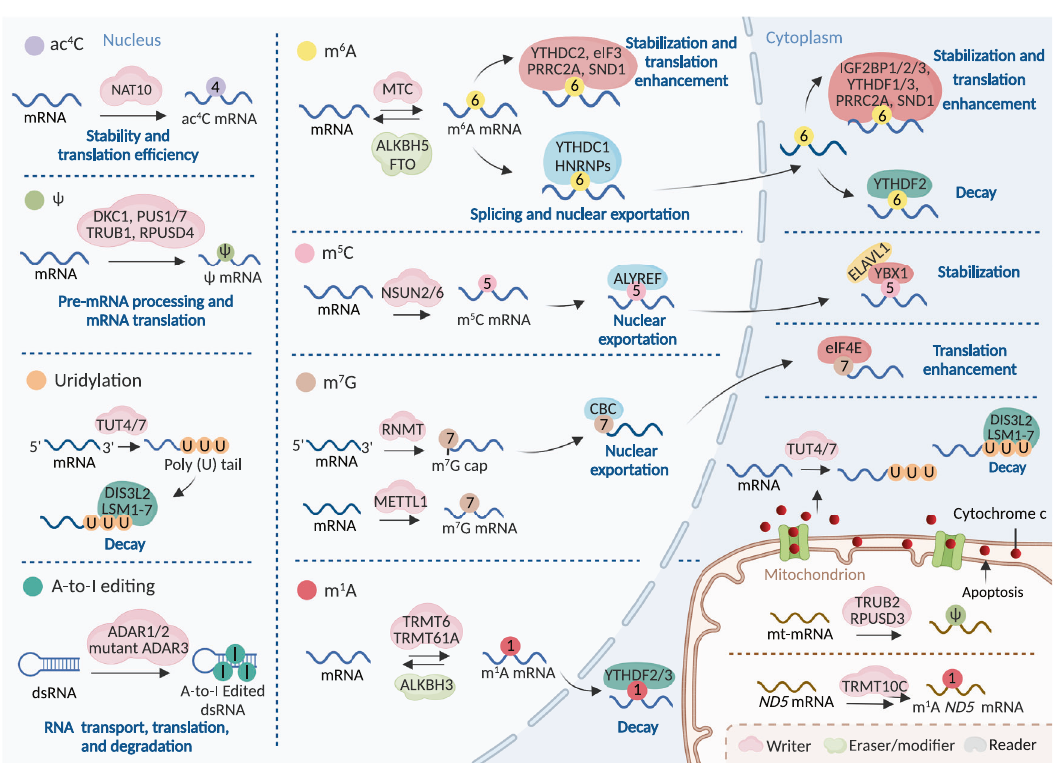
Fig. 2 The machinery of RNA modi fi cations and their molecular functions in mRNA. All RNA modi fi cations included in this review can be installed on mRNA through their writers, and m 6 A as well as m 1 A modi fi cations can be removed by indicated erasers, therefore making these RNA modi fi cations dynamically reversible processes. Some of the RNA modi fi cations can be recognized by their respective reader proteins, which changes the fates of target RNAs via altering generation, transportation, function and metabolization. m 6 A N 6 -methyladenosine, m 5 C 5- methylcytosine, m 1 A N 1 -methyladenosine, m 7 G 7-methylguanosine, ac 4 C N 4 -acetylcytidine, ψ pseudouridine, U Uridine, A-to-I editing adenosine-to-inosine RNA editing, dsRNA double-stranded